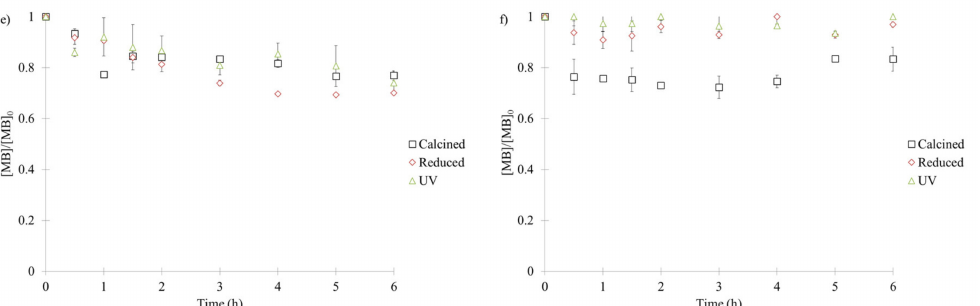
Figure 5. Methylene blue (MB) concentration evolution ([MB] / [MB] 0 ratio) over time (6 h) for all sample series under UV-A illumination: ( a ) pure TiO 2 , ( b ) TiO 2 / SiO 2 , ( c ) TiO 2 / SiO 2 / Pd1, ( d ) TiO 2 / SiO 2 / Pd5, ( e ) TiO 2 / SiO 2 / Pd12 and ( f ) TiO 2 / SiO 2 / Pd22. The contribution of MB adsorption was subtracted for all